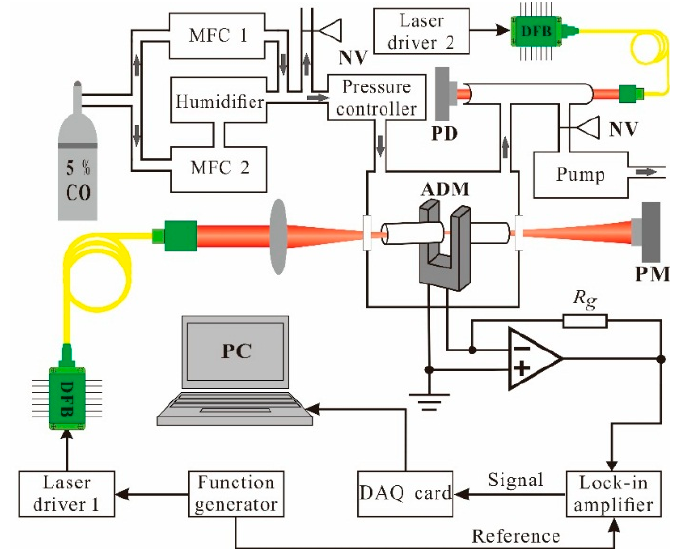
Figure 1. Schematic diagram of the experimental setup. MFC: mass flow controller; PM: power meter; PD: photo detector; NV: needle valve; ADM: acoustic detection module; PC: personal computer.